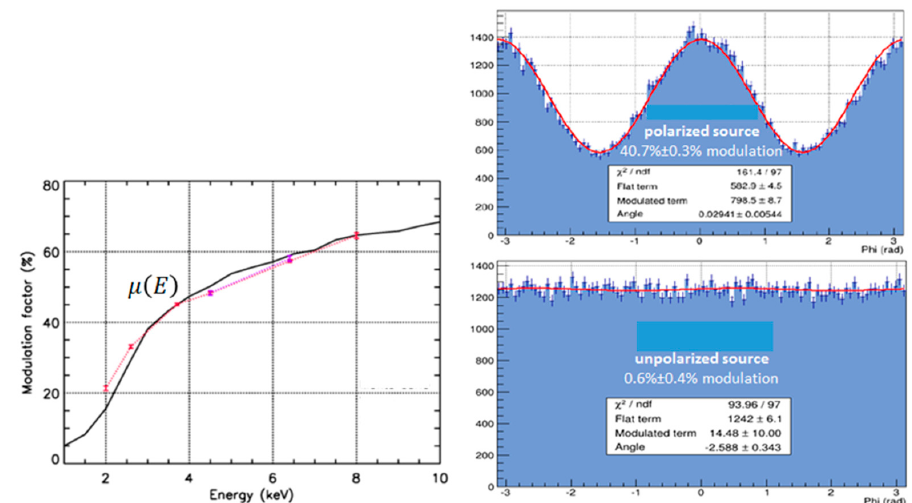
Figure 14. ( Left ) The modulation factor, µ , as a function of energy. The solid line is based on Monte-Carlo simulations. The colored symbols are based on measurements at different times. The dotted lines are simple linear connections; ( upper right ) Measurements of a 99%-polarized source at 3.7 keV; ( lower right ) Measurements of an unpolarized source at 5.9 keV.